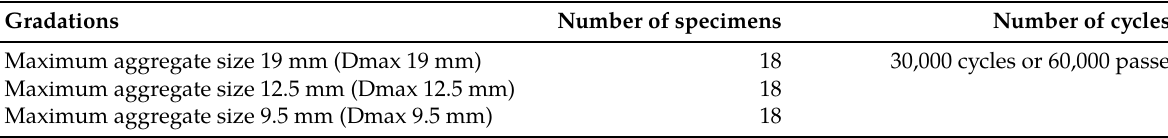
Table 4: Experimental plan for the number of specimens.